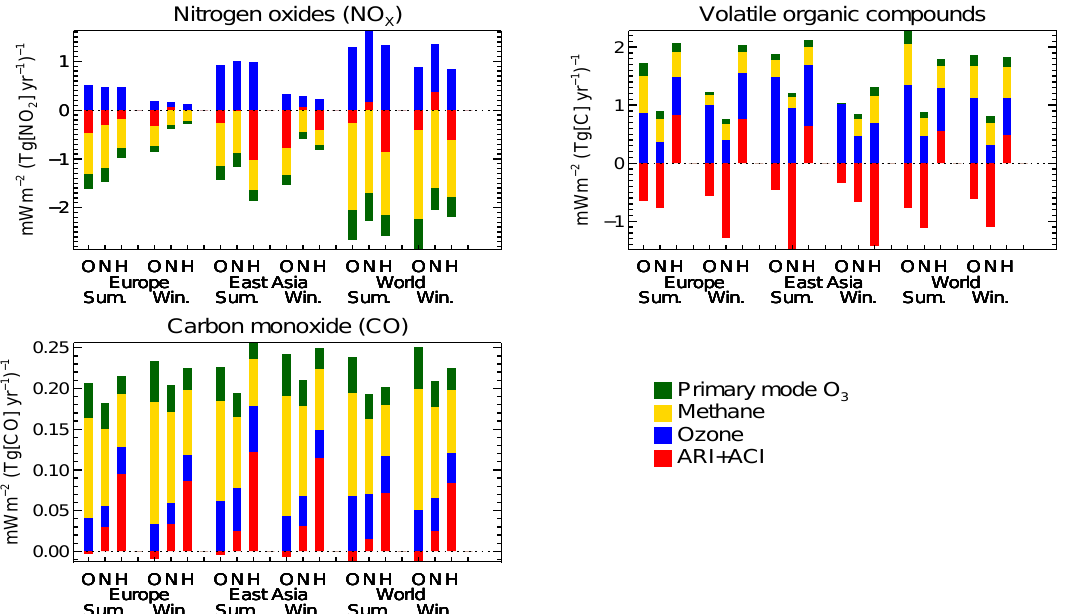
Figure 4. Specific radiative forcing, in mWm − 2 (Tgyr − 1 ) − 1 , for regional and seasonal reductions in nitrogen oxide, volatile organic com- pounds, and carbon monoxide emissions. Results are obtained by three global models: OsloCTM2 (O), NorESM1 (N), and HadGEM3 (H). Four categories of radiative forcing mechanisms are included: aerosol–radiation and aerosol–cloud interactions (red), short-term changes in ozone (blue), methane (yellow), and primary-mode ozone